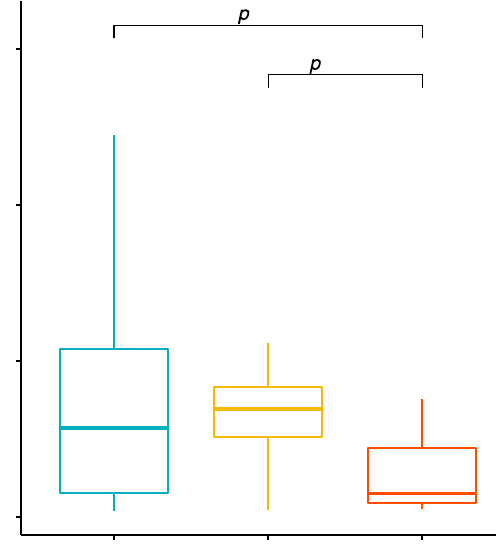
Figure 7. The expression level of TLR-4 on CD8 + T cells (MFI) in patients with GD before treatment, after euthyroidism and in the control group. MFI, mean fluorescence